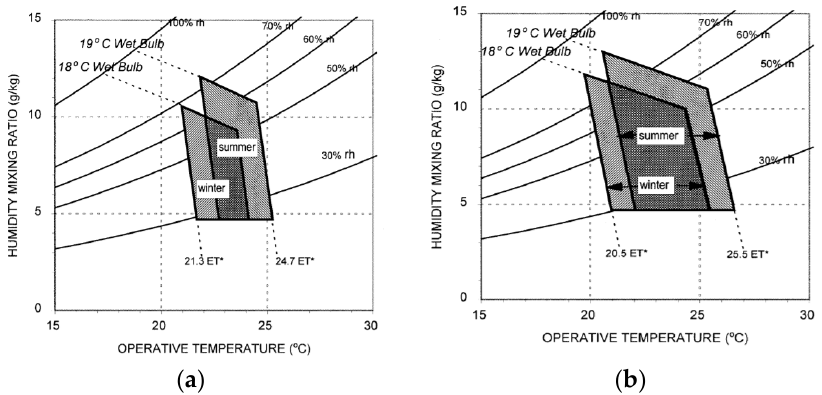
Figure 1. Examples of psychrometric charts for acceptable comfort ranges in winter and summer with different acceptability criteria. ( a ) 90% general acceptability criterion. ( b ) 80% general acceptability criterion [6].